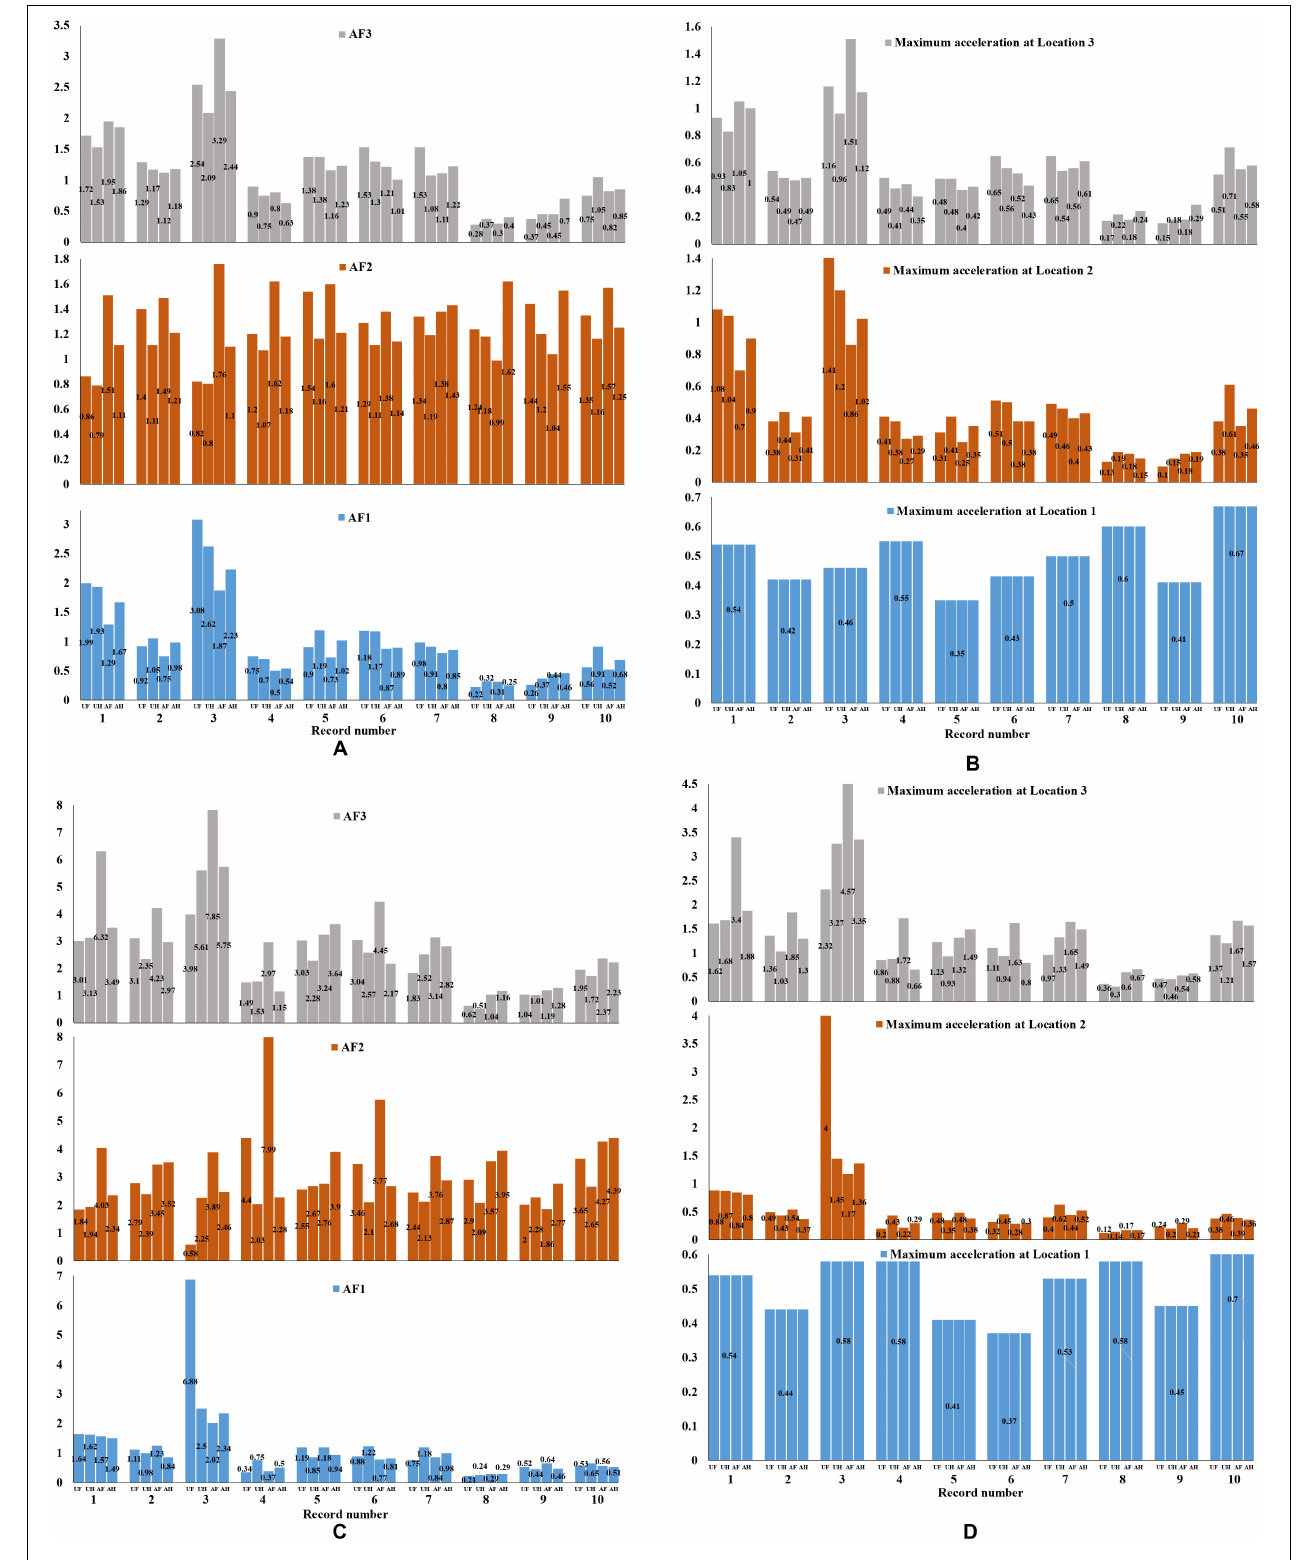
FIGURE 7 | Comparison of the amplification factors (A) and maximum accelerations (B) for the squat and amplification factors (C) and maximum accelerations (D) for the slender tank, for anchored and unanchored conditions (with friction coefficient µ 1 = 0.4) for full-filled (UF and AF) and half-filled (UH and AH) cases.